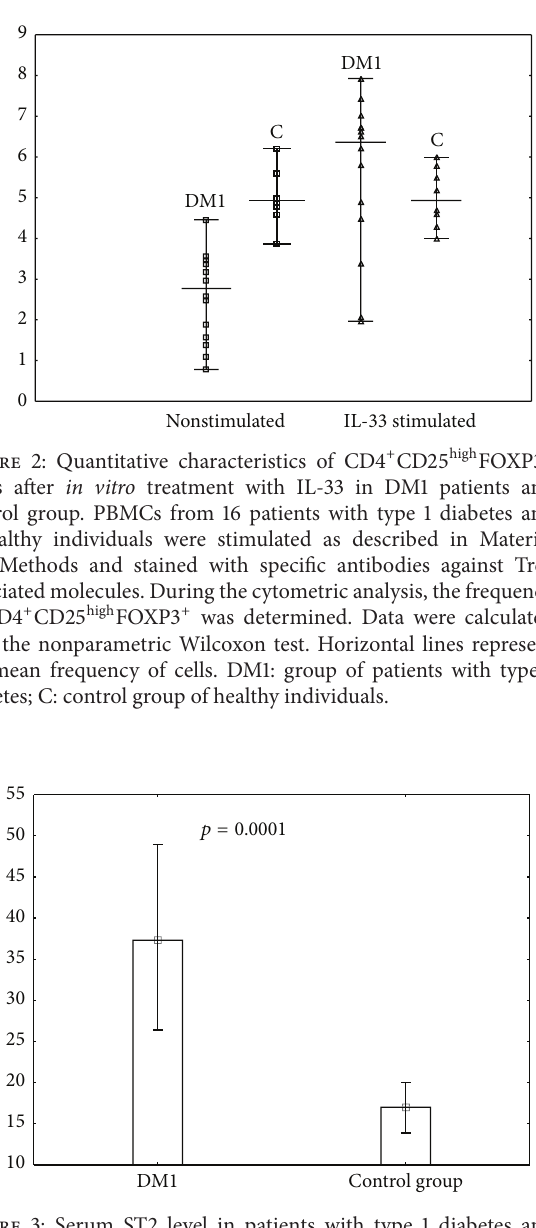
Figure 3: Serum ST2 level in patients with type 1 diabetes and healthy individuals from the control group. The level of serum ST2 (sST2) was measured by ELISA in all study individuals. The mean value (10/90 percentiles) of sST2 was 37.3 (26.4/48.9) and 17 (13.9/20)pg/mL for DM1 and control group, respectively. Differences were calculated by the Mann–Whitney 𝑈